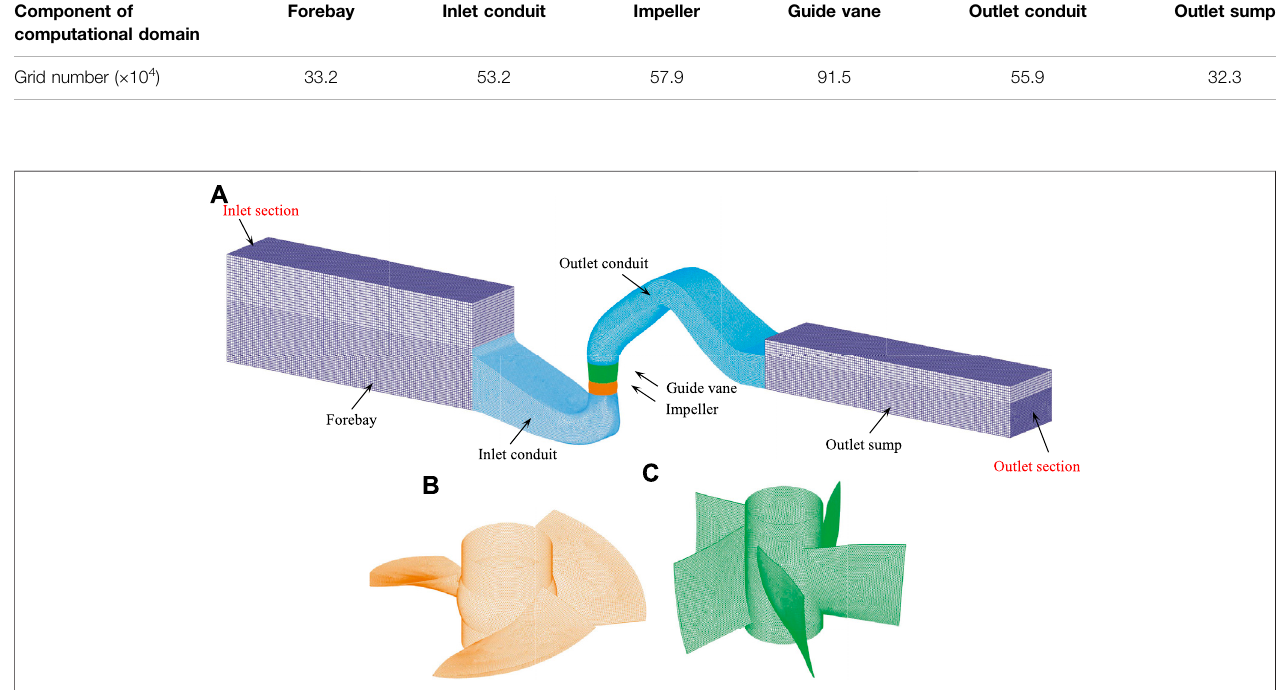
FIGURE 7 | Computational domains and mesh generations of vertical axial fl ow pump device. (A) Pump device, (B) Impeller, (C) Guide vane.